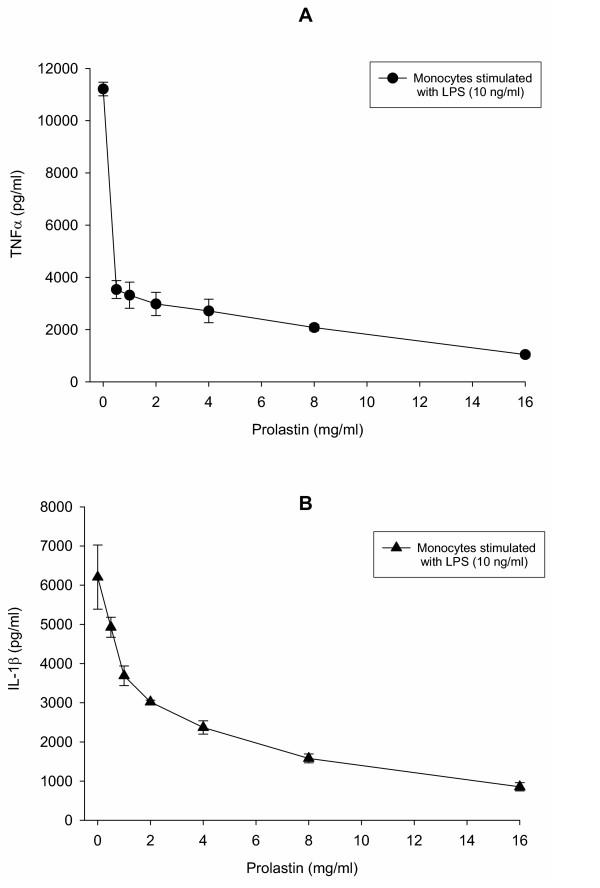
A concentration-response inhibition of lipopolysaccharide-stimulated TNFα (A) and IL-1β (B) release by Prolastin in human blood monocytes. Isolated blood monocytes were treated with LPS (10 ng/ml) alone or together with various concentrations of Prolastin (0–16 mg/ml) for 18 h. TNFα and IL-1β levels were measured by ELISA. Data are the means of quadruplicate culture supernatants ± S.E. and are representative of three separate experiments.